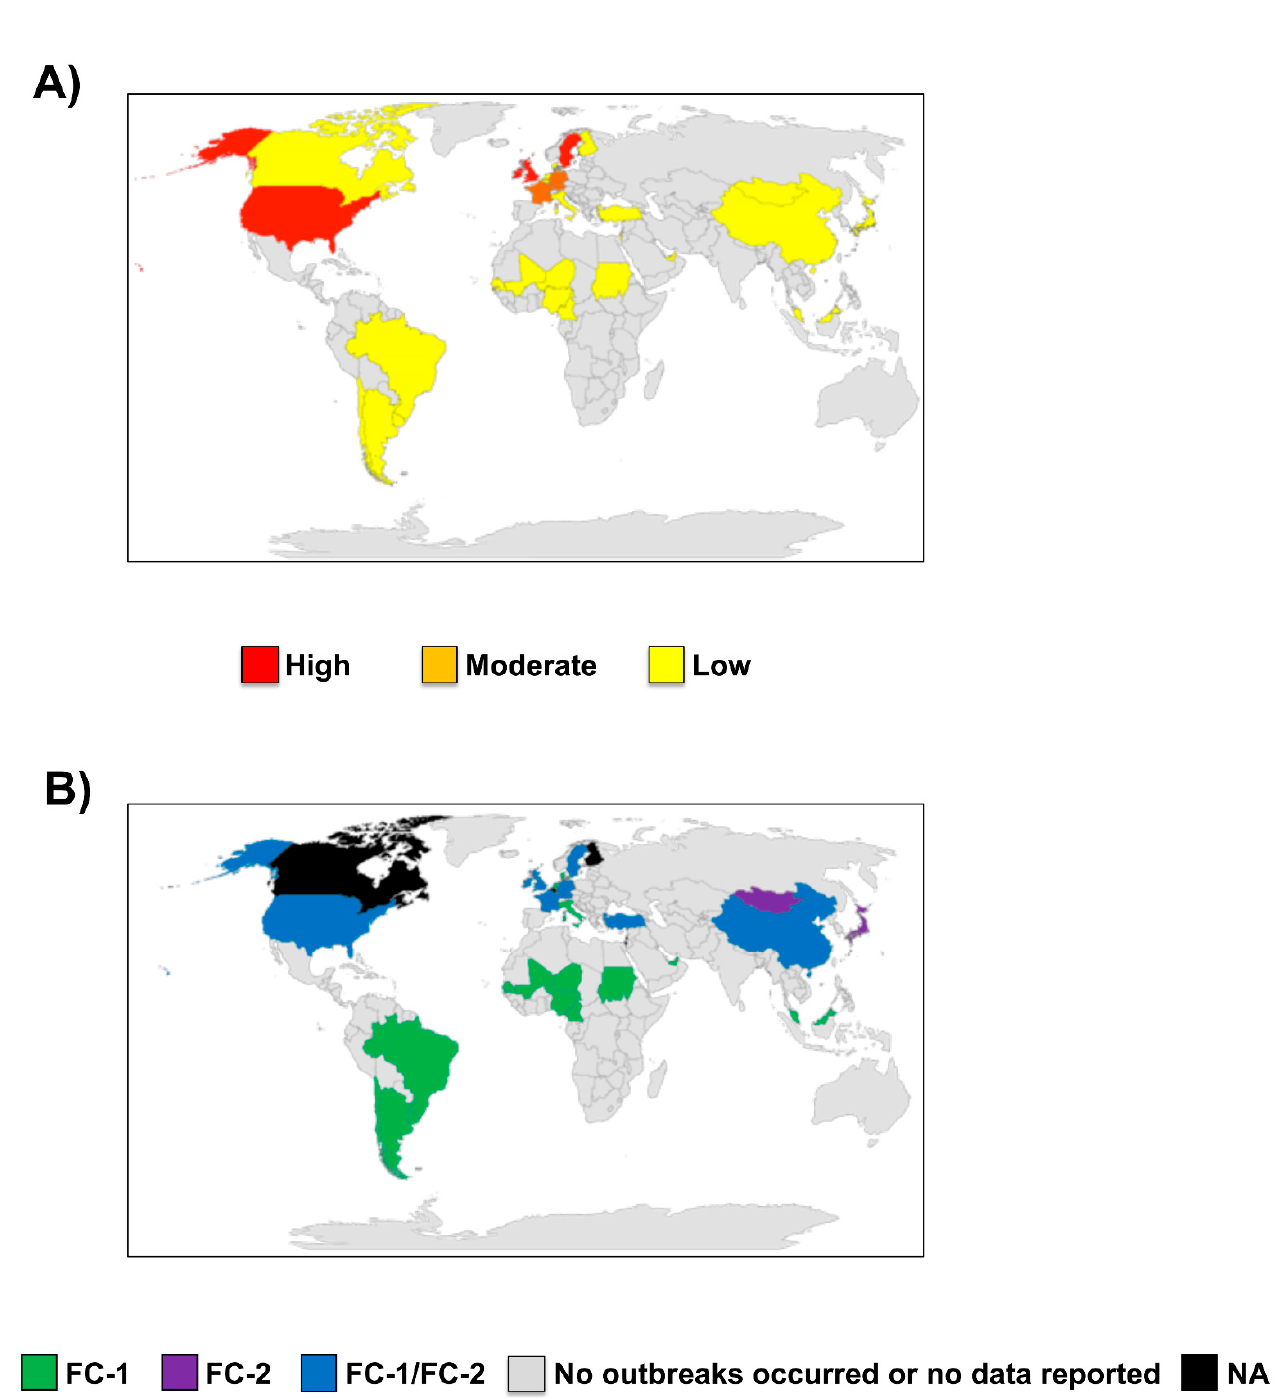
Figure 2. Incidence of EIV in the equine population over the last decade, compiled from OIE ESP on Equine Influenza Vaccine Composition reports, 2010 to 2019. ( A ) Countries are ranked based on the average of incidence rate, i.e., number of years reported to OIE ESP over a period of 10 years. ( B ) Clades responsible for these outbreaks indicated: An incidence rate >50% is classified as high, 50% is moderate, and <50% is low. NA, not available. Data from the genetic characterization of the HA and neuraminidase (NA) genes from EIV isolates from China, France, Ireland, Niger, Nigeria, the UK, the US, Senegal, and Sweden between 2019 and 2020 have been made available. The EIV isolates from China were characterized as the Florida clade 2 (FC-2) of the American lineage, resembling